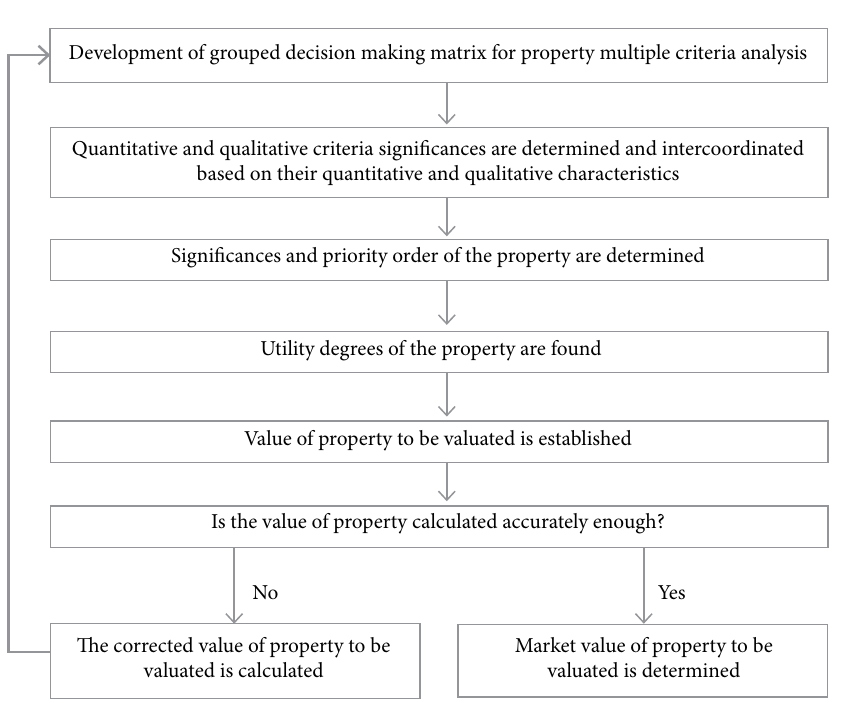
Fig. 3. Block-diagram of property market value